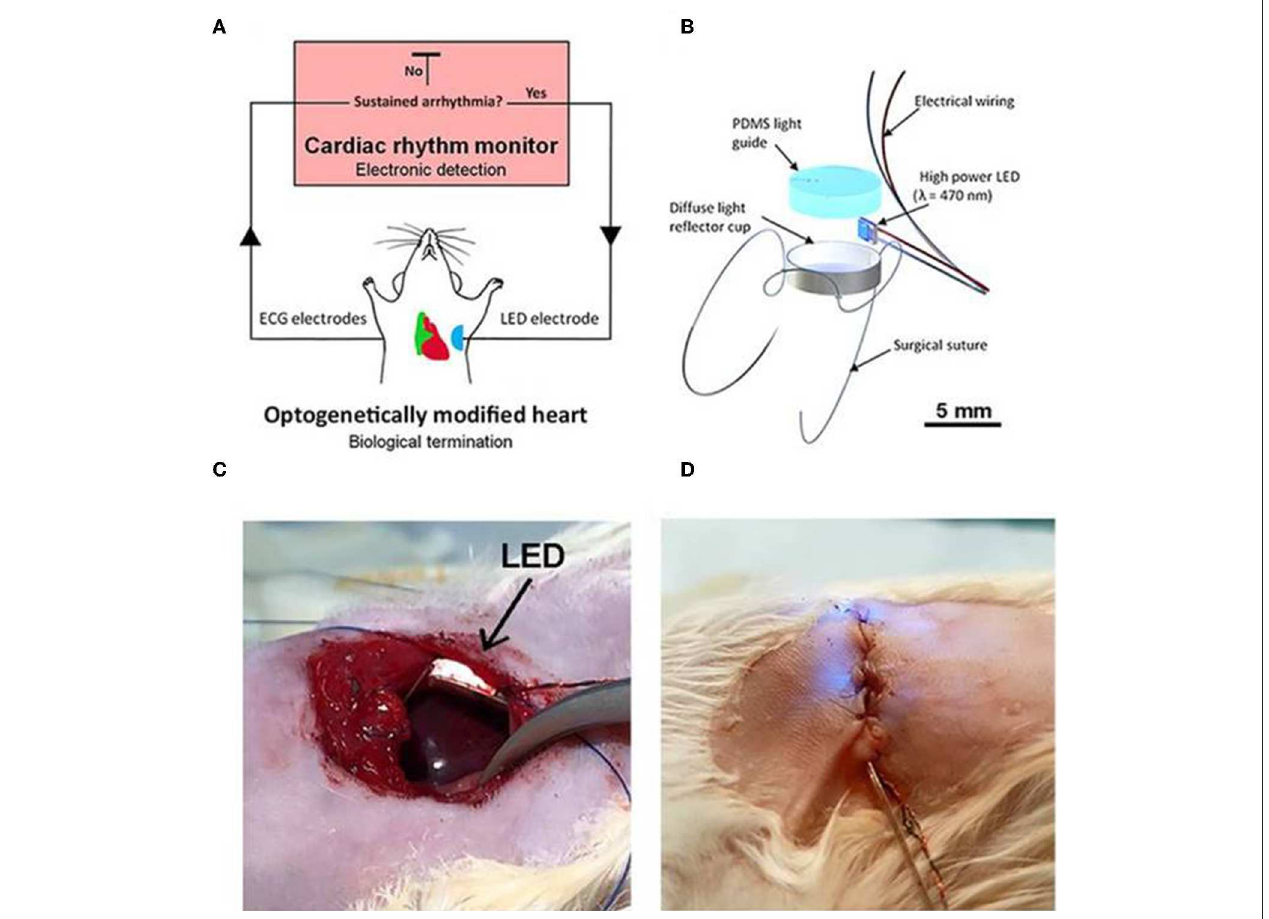
FIGURE 8 | An automated hybrid bioelectric system for the restoration of sinus rhythm during atrial fibrillation. The autogenous bioelectric system comprises of an opsin expressing right atrium (green), a cardiac rhythm monitor, and ECG electrodes, where the ECG signal is fed as input to the cardiac monitor (A) . Abnormalities in ECG recordings, such as during atrial fibrillation, causes an output signal that triggers ON the implantable LED device (500ms) which activates ReaChR in the atrium; the activation of the latter terminates fibrillation and restores normal sinus rhythm. Detail on the LED assembly (B) , experimental details on LED implantation procedures, before (C) and after the chest closure (D) , respectively, are illustrated. LED is held firmly on the thoracic wall and on the top of the right atrium without any physical contact to the heart (C) . Electrical wires for pacing and turning on LED are shown in (D) . Reproduced with permission from Nyns et al.